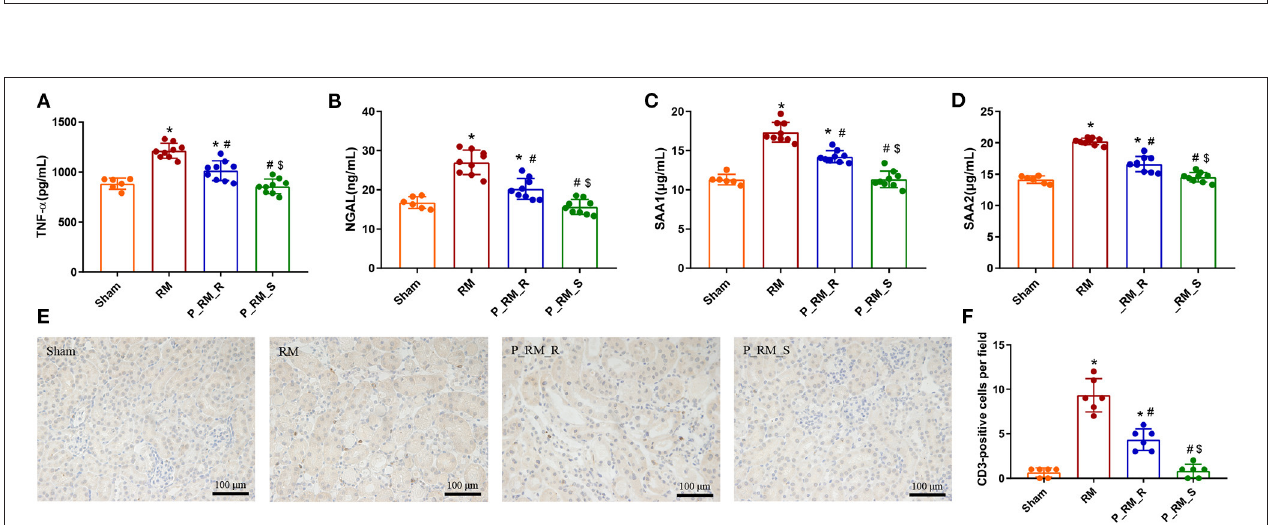
FIGURE 6 | Exogenous biological renal support decreased oxidative stress in RM-induced AKI. (A–D) The levels of MDA, SOD, GSH, and PC were measured by ELISA. MDA, malondialdehyde; SOD, superoxide dismutase; GSH, glutathione peroxidase; PC, protein carbonyl; RM, rhabdomyolysis; P_RM_R, the mouse in the parabiosis model administered glycerol; P_RM_S, the other mouse in the parabiosis model supplying the exogenous biological renal support. * P < 0.05 vs. the sham group; # P < 0.05 vs. the RM group; $ P < 0.05 vs. the P_RM_R group.